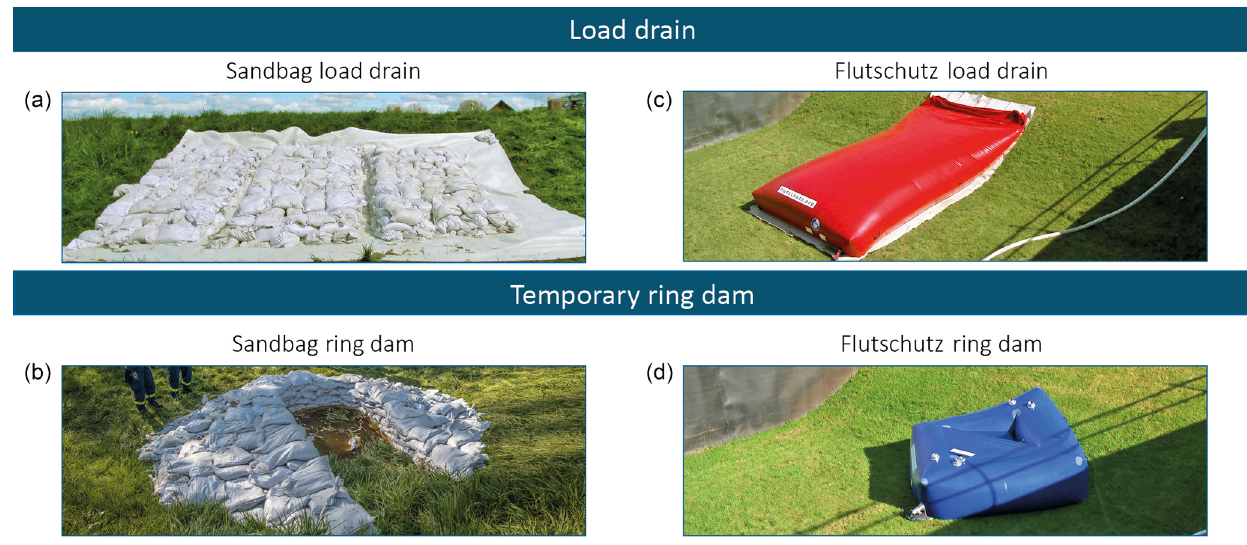
Figure 3. Dike defence measures for a saturated dike over an extensive area (load drain) and for heavy punctual seepage discharge (temporary ring dam). Sandbagging systems (a, b) and corresponding SBRSs (c, d) are shown.